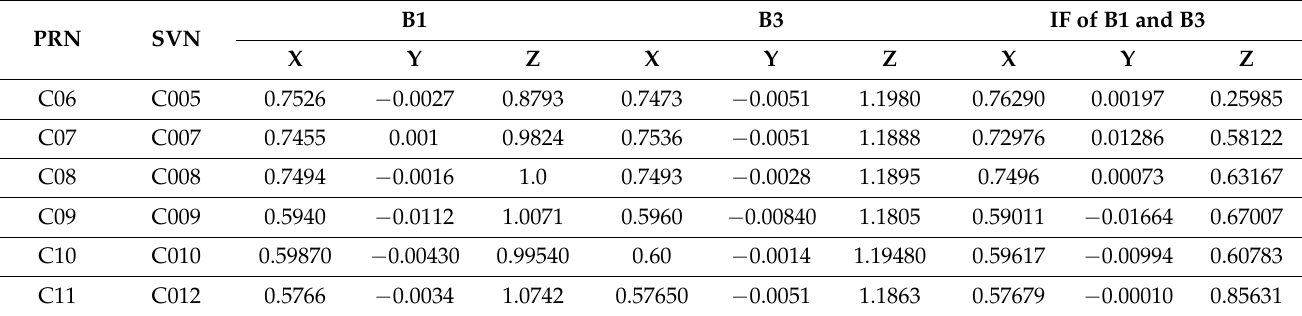
Table 1. Officially released phase center offset (PCO) information of B1 and B3, as well as their ionosphere-free combination for BDS IGSO and MEO satellites (unit: m). PRN